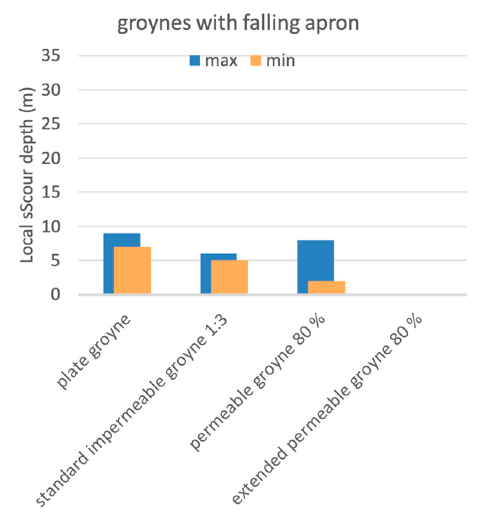
Figure 7. The maximum local scour depth near different types of groynes without falling aprons in physical model tests.